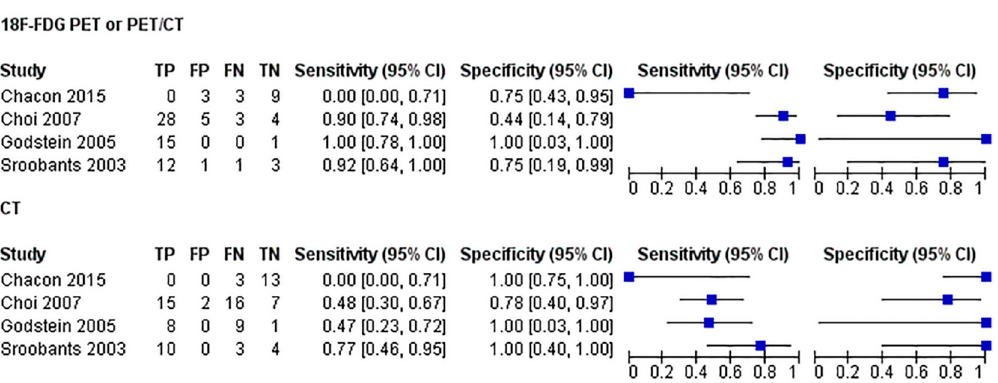
Figure 3. Forest plots (of sensitivity and specificity) of [ 18 F]FDG PET or PET/CT and CT and pooled the diagnostic